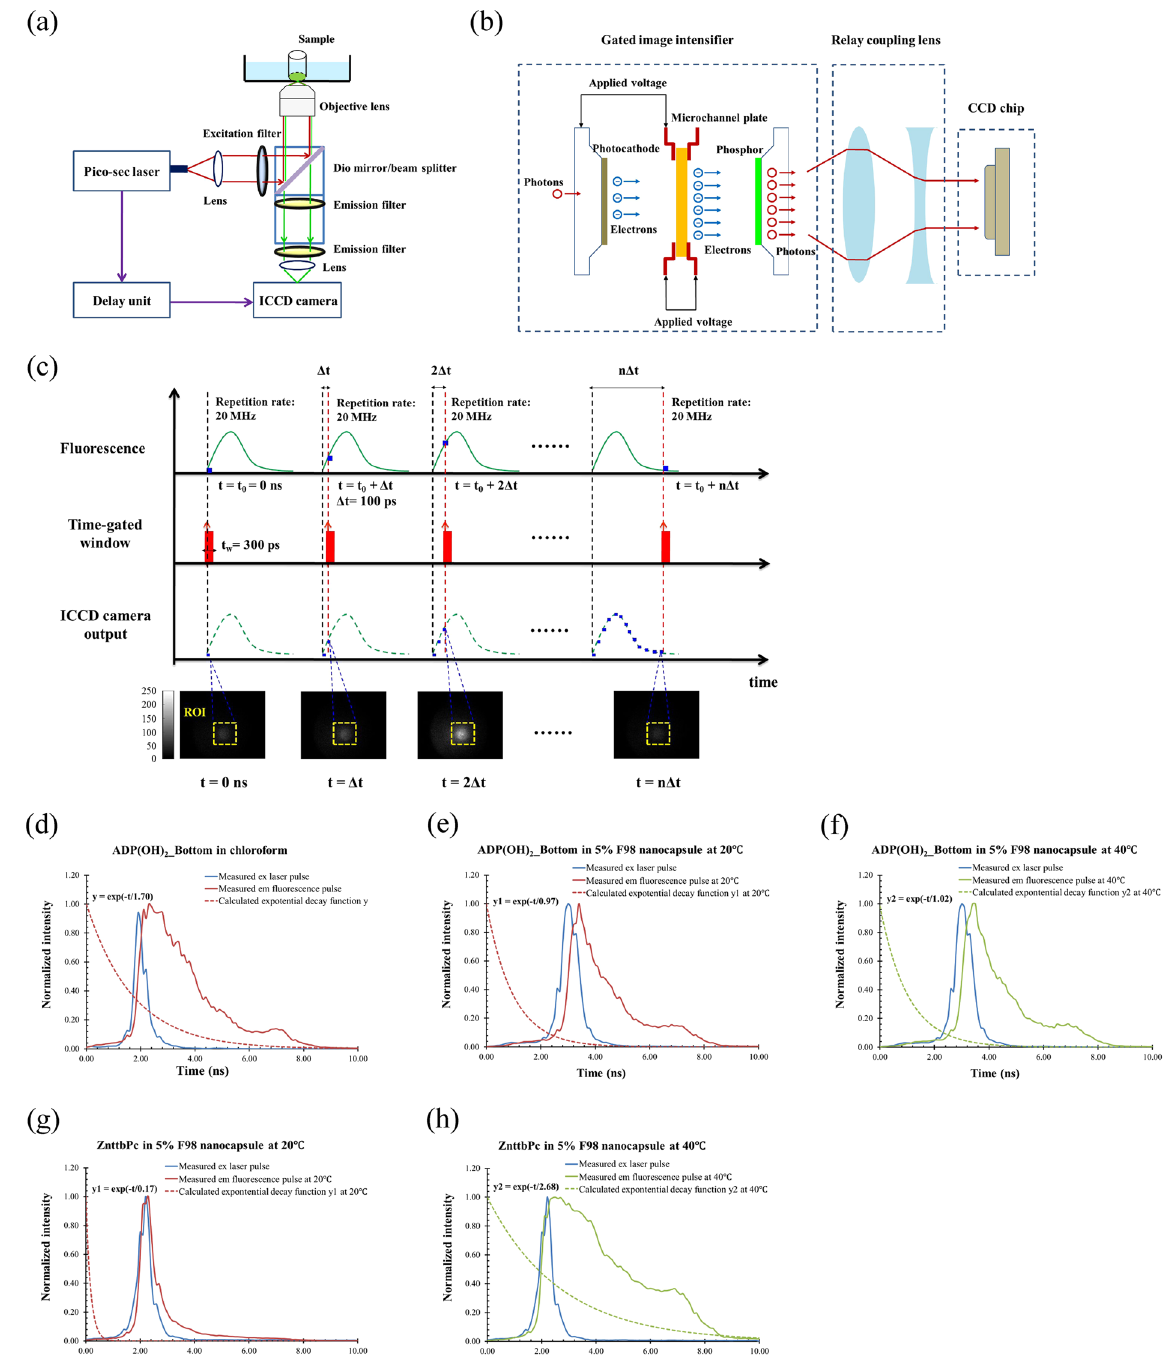
Figure 1. ( a ) Time-domain fluorescence measurement system. ( b ) Schematic diagram of the gated ICCD camera. ( c ) Principle of measuring the fast fluorescence decay signal after excited by a short laser pulse via the gated ICCD camera. ( d ) The measured fluorescence lifetime of the fluorophore of ADP(OH) 2 -Bottom in chloroform. ( e ) The measured fluorescence lifetimes of ADP(OH) 2 -Bottom in 5% pluoronic F98 nanocapsule at 20 °C. ( f ) The measured fluorescence lifetimes of ADP(OH) 2 -Bottom in 5% pluoronic F98 nanocapsule at 40 °C. ( g ) The measured fluorescence lifetimes of ZnttbPc in 5% pluoronic F98 nanocapsule at 20 °C. ( h ) The